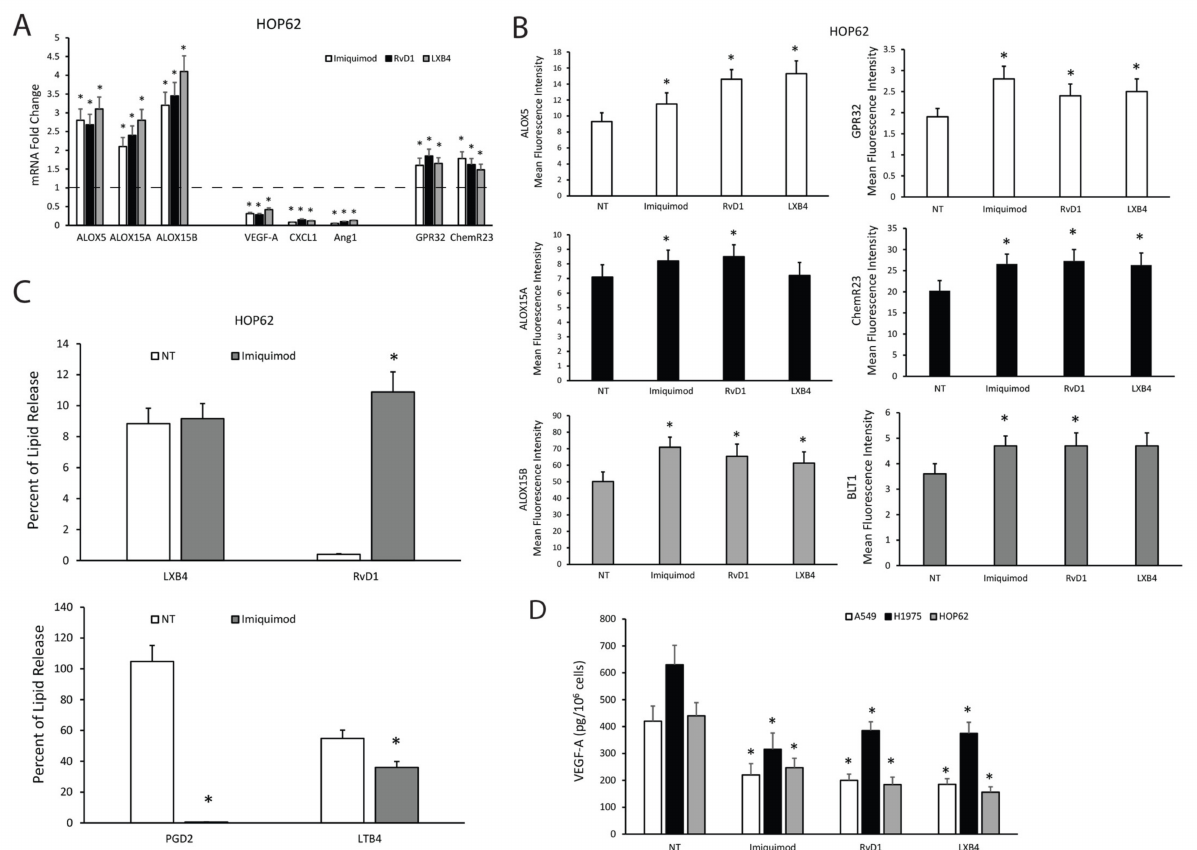
Figure 4. Effects of TLR7 activation on SPM biosynthetic machinery and angiogenic potential of NSCLC cells. ( A ) ALOX5, ALOX15A, ALOX15B, VEGF-A, CXCL1, Ang1, GPR32, and ChemR23 mRNA fold change in HOP62 cells treated with imiquimod (1 µ g/mL), RvD1 (1 nM), or LXB4 (1 nM) for 3 h. Data are represented as mean ± SD of five independent experiments. * p < 0.05 compared to the control (dotted line). ( B ) ALOX5, ALOX15A, ALOX15B, GPR32, ChemR23, and BLT1 protein expression levels (mean fluorescence intensity), assessed by cytofluorimetric analysis, in HOP62 cells treated with imiquimod (1 µ g/mL), RvD1 (1 nM), or LXB4 (1 nM) for 6 h. Data are represented as mean ± SD of three independent experiments. * p < 0.05 compared to the control (NT). ( C ) Pro-resolving and pro-inflammatory autacoids (LXB4, RvD1, PGD2, and LTB4) release in HOP62 cells treated or untreated with imiquimod (1 µ g/mL, 18 h). Data are represented as mean ± SD of five independent experiments. * p < 0.05 compared to the control. ( D ) VEGF-A release in A549, H1975, and HOP62 cells treated with imiquimod (1 µ g/mL), RvD1 (1 nM), or LXB4 (1 nM) for 10 h. Data are represented as